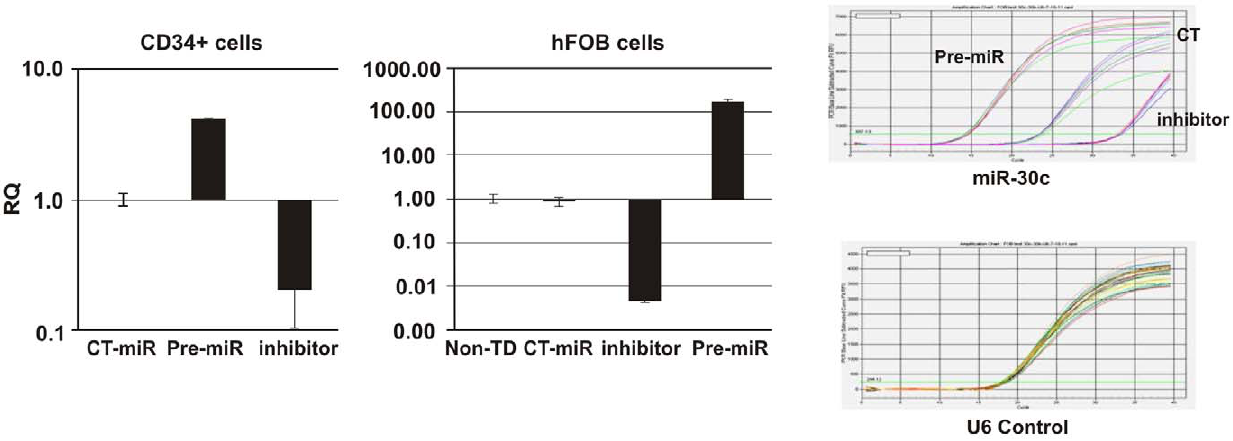
Figure 4. hsa-miR30c regulation by pre-miR30c or miR30c-inhibitor in human CD34 + and hFOB Cells. The pre-miR30c, miR30c inhibitor, or control miR (CT-miR) molecules were transfected into CD34 + cells and hFOB cells. miR30c expression was examined 24 h post-transfection by quantitative RT-PCR. U6 was used as a loading control. RQ: relative quantification. Non-TD: miRNA-untransfected control.